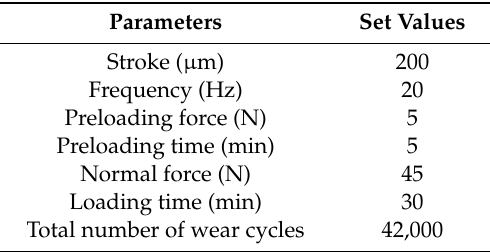
Table 3. Parameters of fretting wear test.